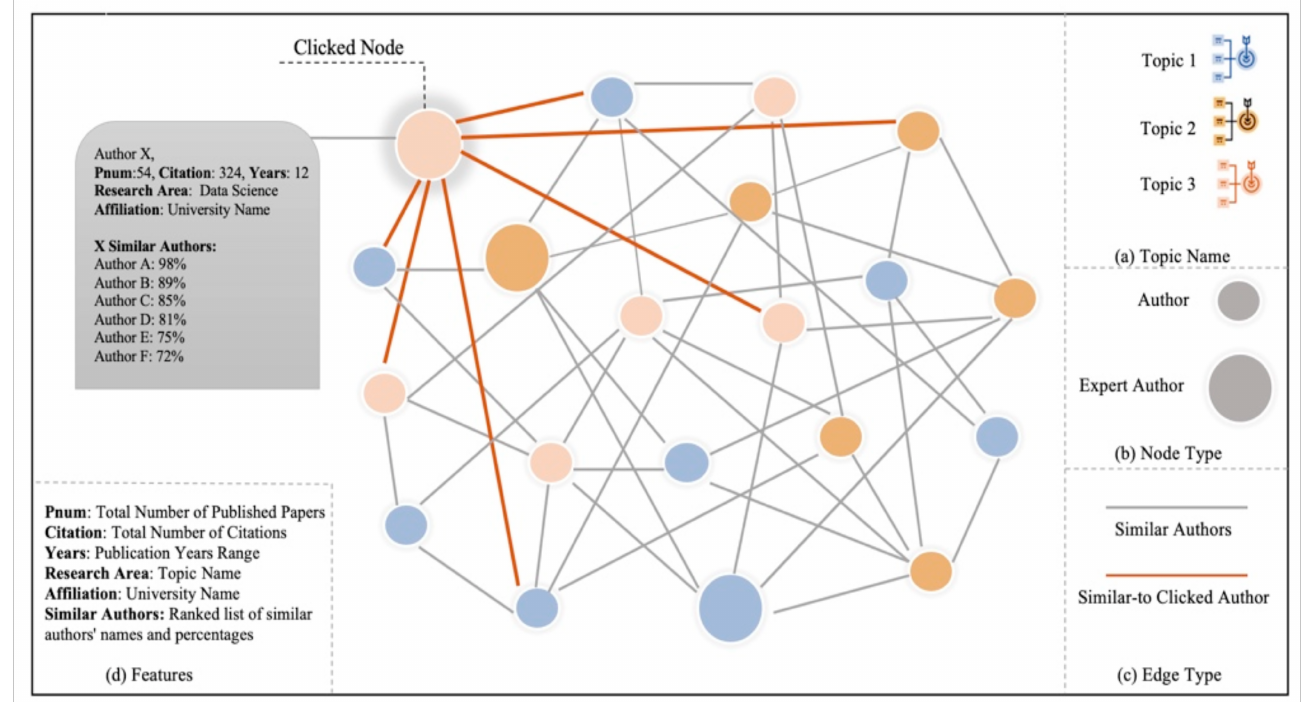
Figure 8. Informative representations of the proposed interactive network.